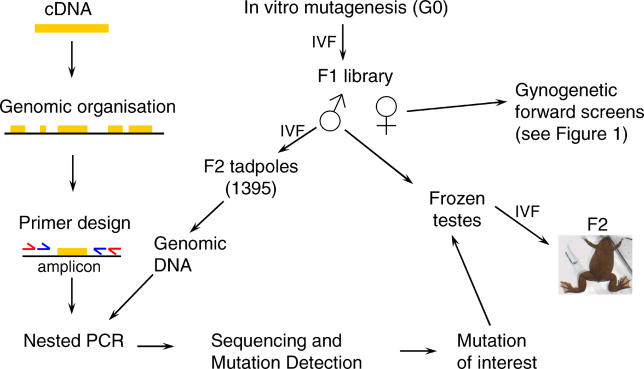
Reverse Screen StrategyENU-treated sperm (G0) was used to fertilize wild-type eggs (in vitro fertilization), and the resulting F1 families raised to adulthood. F1 males were killed and their testes dissociated, with a portion used to generate F2 tadpoles and the remainder frozen in several aliquots per individual (F1 library). F1 females were used in the gynogenetic forward screens (see Figure 1). F2 genomic DNA was isolated from the tadpoles for reverse genetic (TILLING) screens. Known genomic sequences were used to design nested PCR primers, and then individual F2 tadpole amplicons were sequenced to detect induced mutations. Mutations are then recovered from frozen testes by in vitro fertilization for subsequent phenotypic analysis.